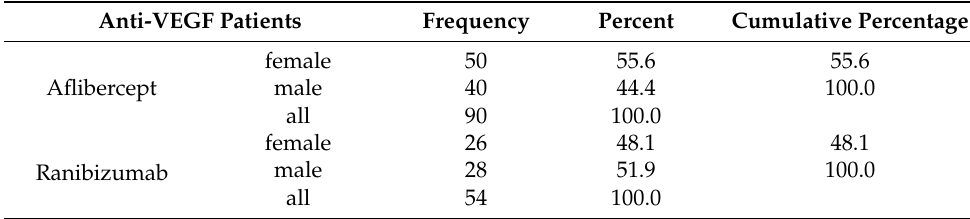
Table 1. Characteristics of the groups in terms of gender.